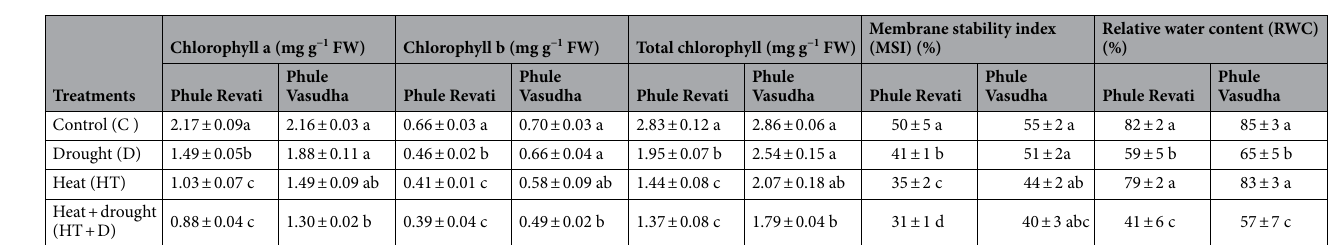
Table 1. Effect of stress treatment on chlorophyll content, membrane stability index, and relative water content of Phule Revati and Phule Vasudha. The data represent mean values ± SE (n = 8). Values with different letters indicate a significant differences with P <